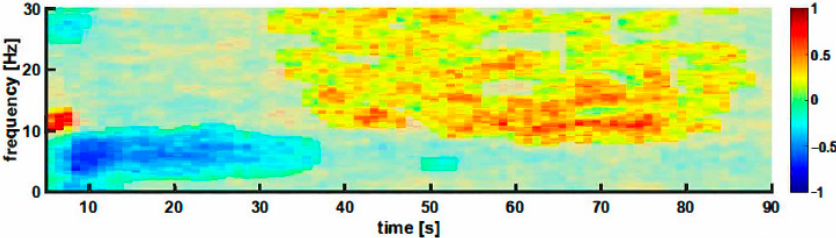
Figure 2. DSA of the Pooled Median Response ( n = 44) to Interdigital Pinch Stimulation over 90 s. Areas with bold colours indicate the frequency and time regions with significant differences between pre- and poststimulus conditions. The colour bar indicates the change in the poststimulus power compared with the prestimulus baseline. The stimulus started at t = 0. Briefly, the interdigital pinch leads to an ‘early‘ reduction in power in the slow frequencies below 10 Hz and a ‘late‘ activation of higher frequencies above 10 Hz starting approximately 35 s after the